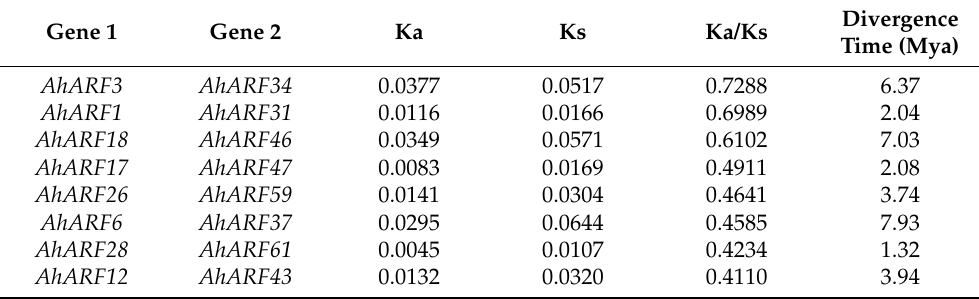
Table 1. The nonsynonymous (Ka) and synonymous (Ks) substitution rates of orthologue AhARF pairs in A. hypogaea